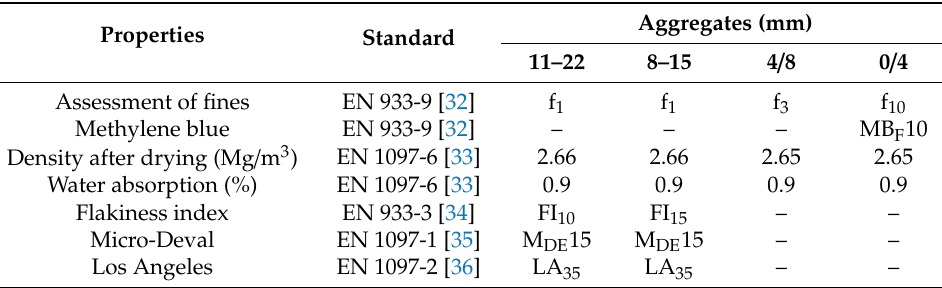
Table 1. Aggregates’